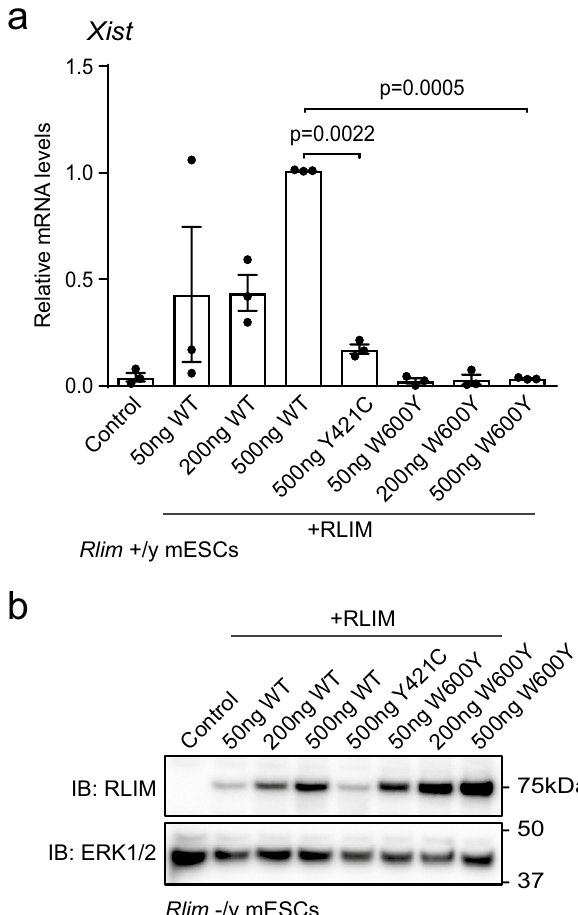
Figure 4. RLIM p.(Tyr421Cys) is functionally impaired in an assay for Xist lncRNA induction. ( a ) Human RLIM wild-type (WT), Y421C TOKAS variant or W600Y catalytically-inactive variant were expressed at increasing amounts (50–500 ng plasmid DNA) in Rlim +/y mESCs. Xist lncRNA expression was determined by qRT-PCR and normalised to Gapdh mRNA expression. Data are represented as mean ± standard error of the mean (n = 3). Statistical significance was determined by one-way ANOVA. Figure was generated using Graphpad Prism v8.0 (https:// www. graph pad. com/ scien tific- softw are/ prism/). ( b ) Human RLIM wild-type (WT) or W600Y catalytically-inactive variant were expressed at increasing amounts (50–500 ng plasmid DNA) in Rlim -/y mESCs. The RLIM Y421C TOKAS variant was expressed only at the maximum amount of plasmid DNA (500 ng) to enable comparison with similar levels of RLIM WT or Y421C expressed at lower amounts of plasmid DNA. RLIM expression was determined by immunoblotting and ERK1/2 expression analysed as a loading